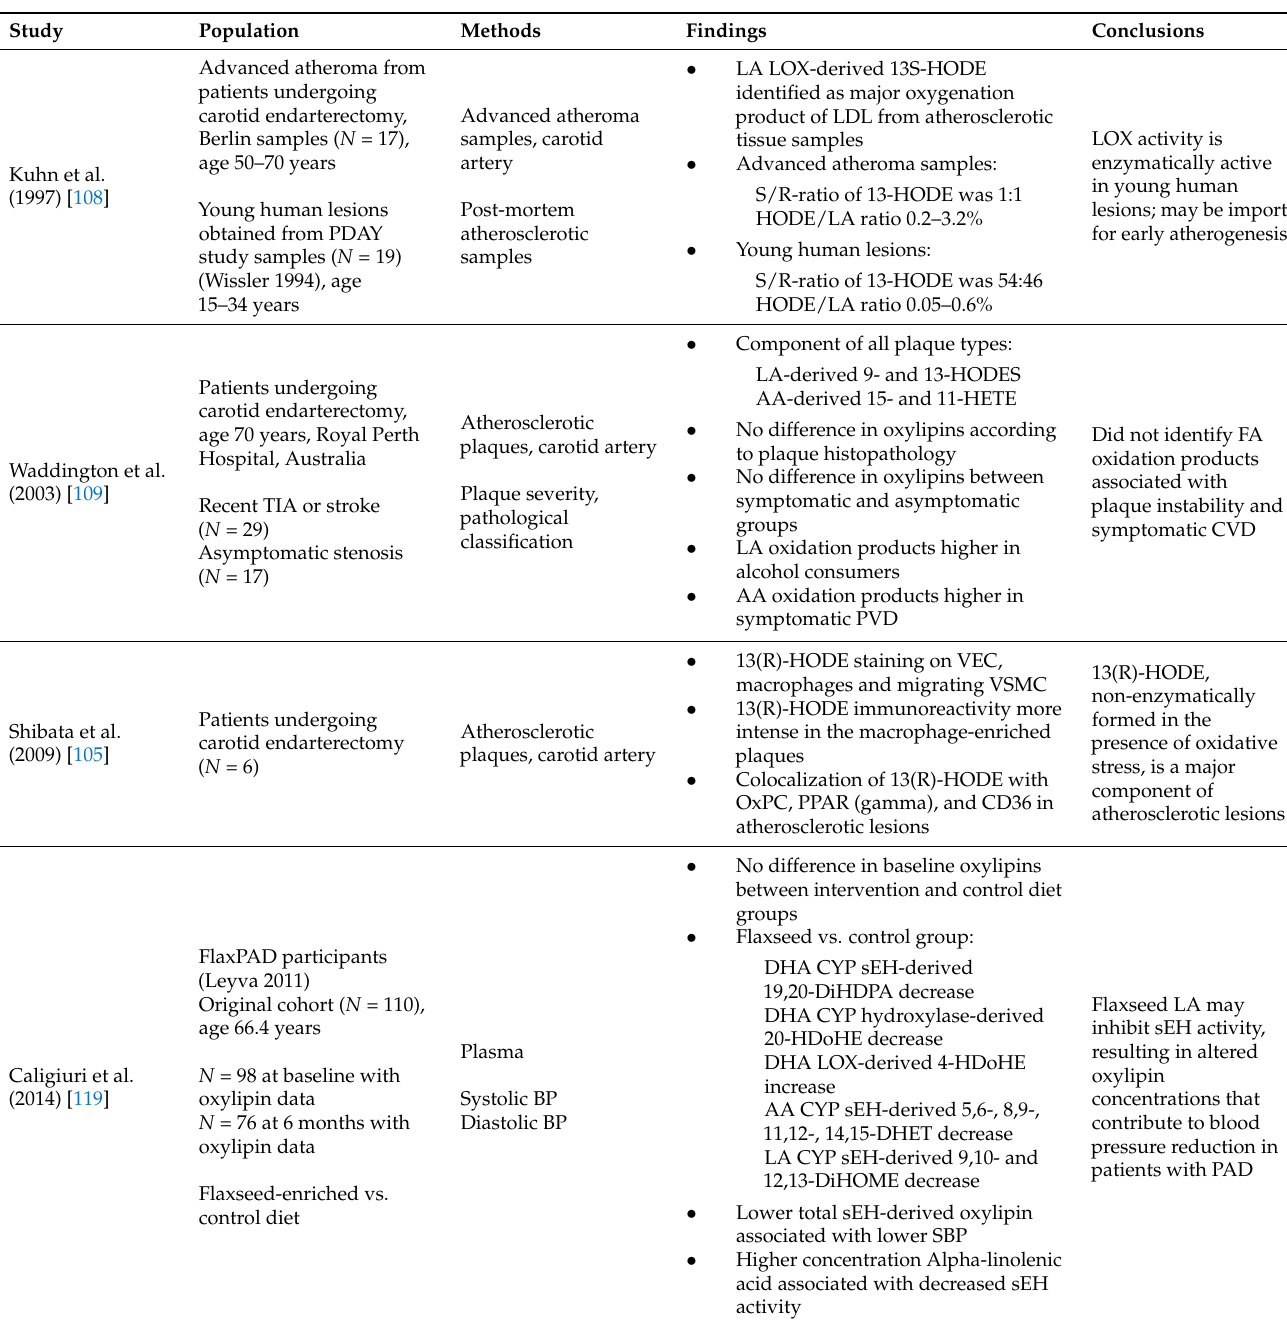
Table 1. Summary table of oxylipin studies involving human